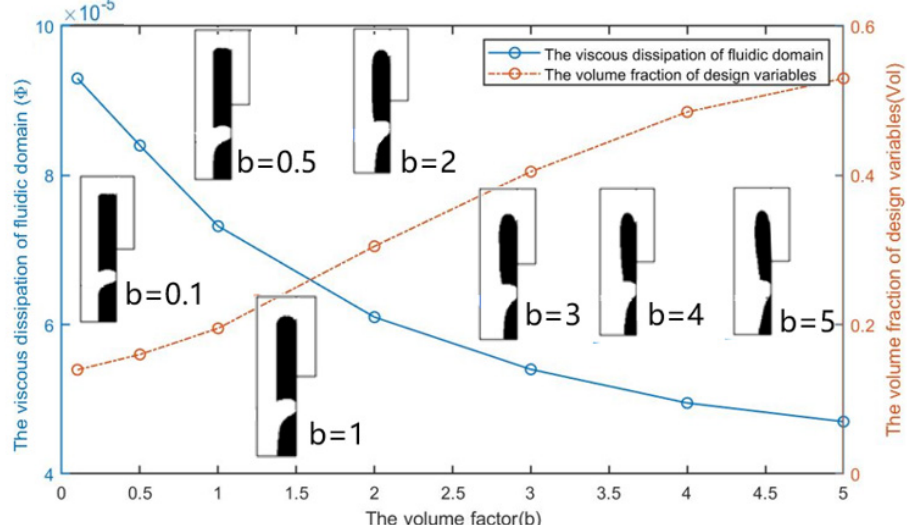
Figure 4. The optimization results and the effect of the volume coefficient b on the volume fraction vol of design variables and the viscous dissipation Φ of fluidic domain.